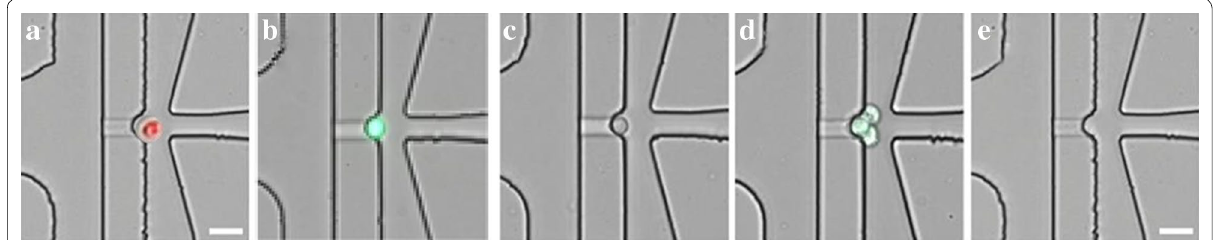
Fig. 2 Single‑cell widefield representative images acquired by an automated device (C1 Fluidigm chip). a Cell stained with ethidium homodimer‑1 (EthD‑1, red ) labeling unhealthy or dead cells. b Single GFP + cell. c Single GFP − cell. d Capture site containing three cells. e Empty capture site (Figure adapted from